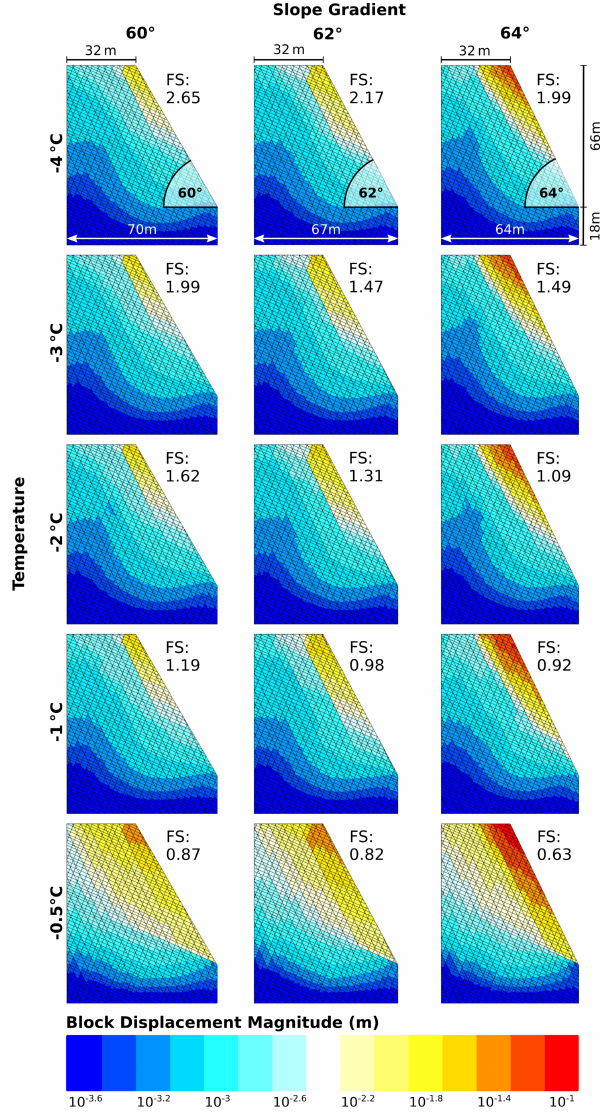
Figure 7. Numerically calculated block displacements (on a log scale) for a simplified rock slope geometry with exemplary incli- nations of 60, 62 and 64 ◦ , and five temperatures between − 4 and − 0 . 5 ◦